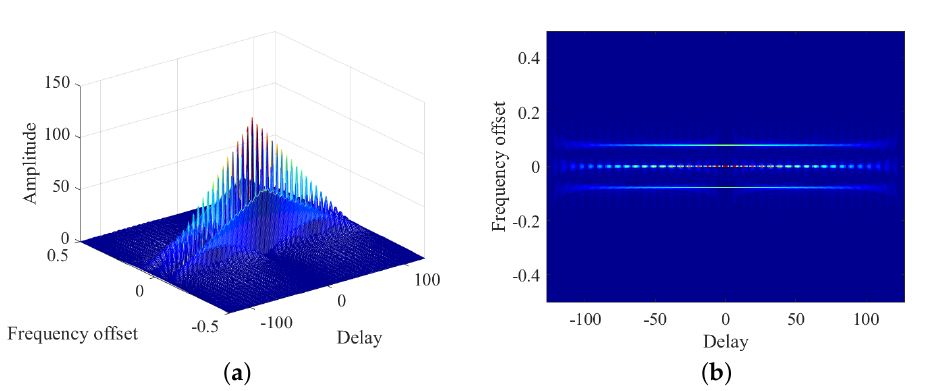
Figure 1. AF of single-frequency signal. ( a ) Three-dimension map of AF ( b ) Two-dimension map of AF.